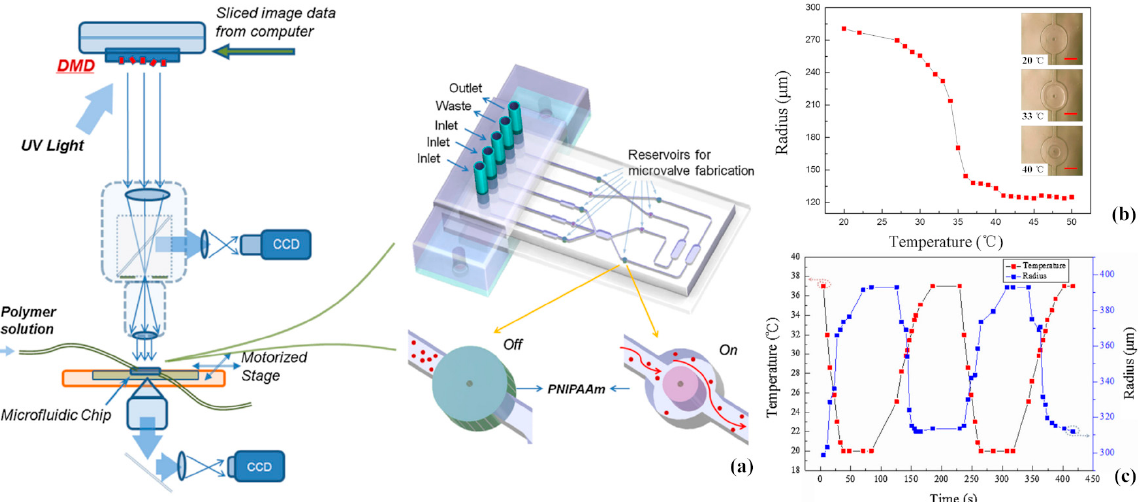
Figure 10. Microfluidic chip integrated with PNIPAM microvalves: ( a ) Schematic drawing of the PNIPAM microvalve; ( b ) Radius of PNIPAM microvalve with temperature; ( c ) Temperature cycling test results of PNIPAM microvalve with temperature. Reprinted with permission from [122].